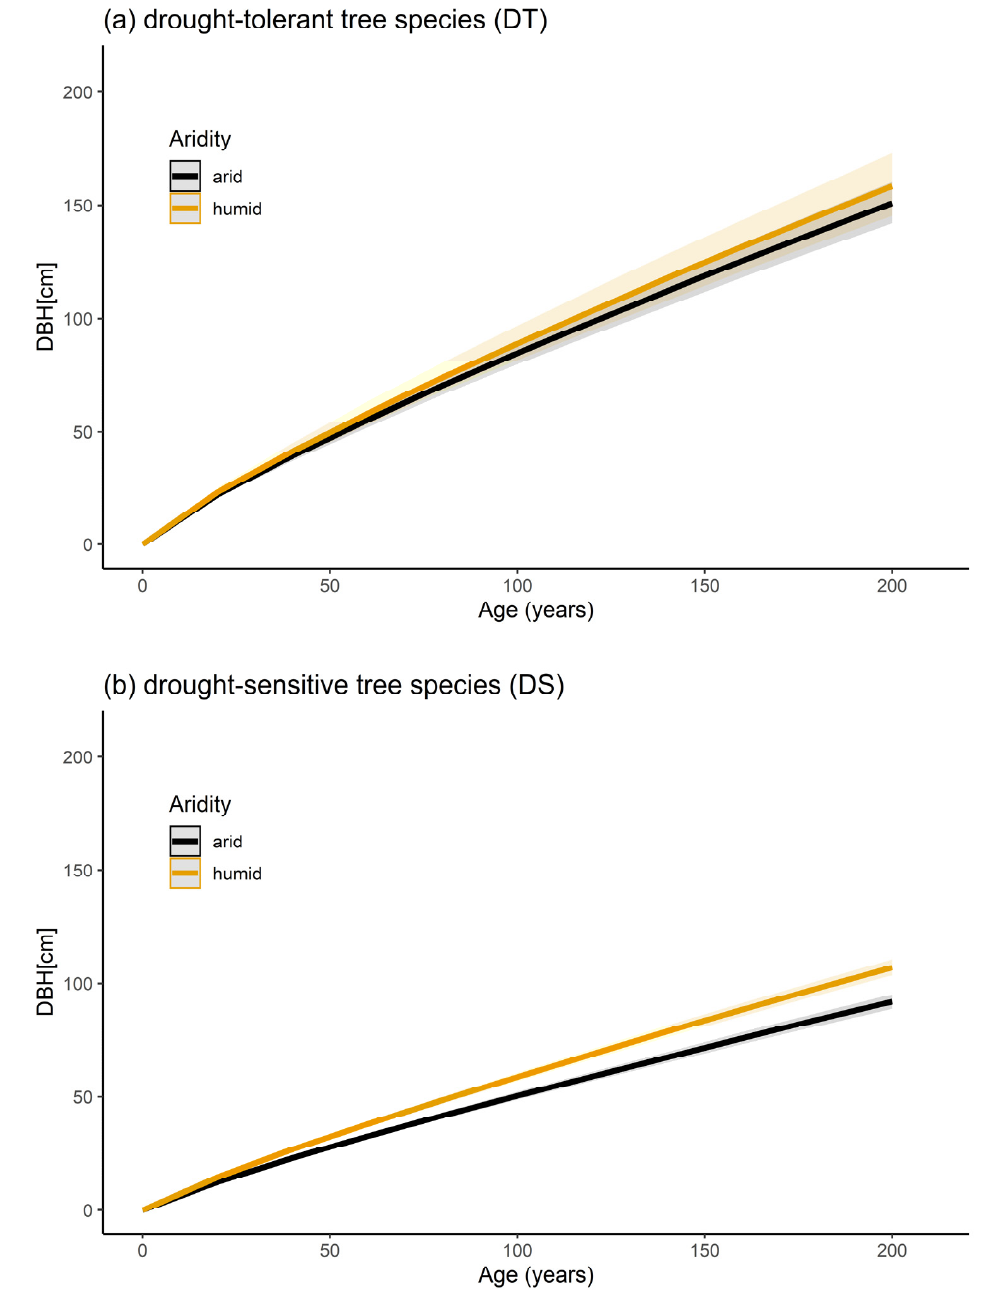
Figure 3. Stem diameter growth reaction of drought-tolerant (DT, ( a )) and drought-sensitive (DS, ( b )) urban tree species depending on the climate, based on model Equation (3) (see Table A1 for model parameters). Black curves visualize the diameter growth under arid climatic conditions (corresponding to the 2.5th quantile of a DMI avg-level, DMI avg = 13 for DT and DMI avg = 30 for DS). Orange curves visualize the diameter growth in humid climatic conditions (corresponding to the 97.5th quantile level of the DMI avg, 52 and 53 for DT and DS, respectively). The shaded bands visualize the prediction confidence interval of the curves.